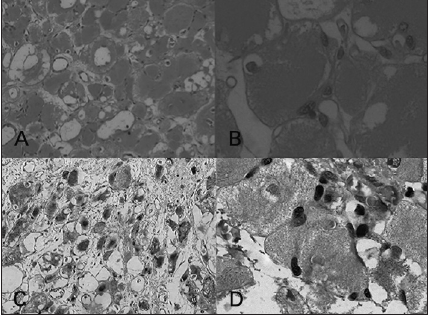
Figura 1. A: Coloração Hematoxilina-Eosina (Aumento 100x); B: Coloração Hematoxilina-Eosina (Aumento 400x); C: Desmina (Aumento 100x);D: Myo D1 (Aumento